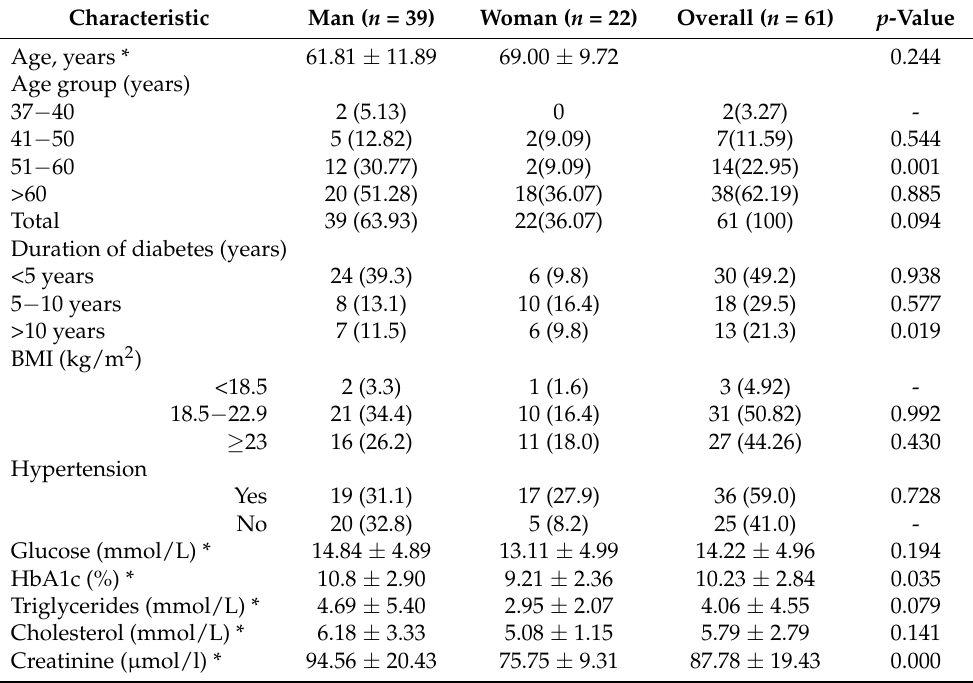
Table 1. The demographic and clinical characteristics of the study